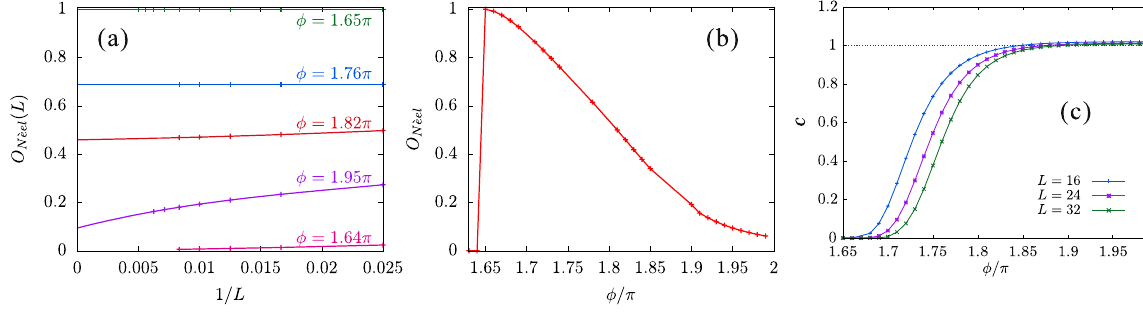
 with polynomial fitting functions. Figure 6. ( a ) Finite-size scaling analyses for the Néel- z order parameter é N el  to the themodynamic limit as a function of φ . ( c ) Central charge, calculated ( b ) The extrapolated values of é N el with periodic chains, as a function of φ for several chain